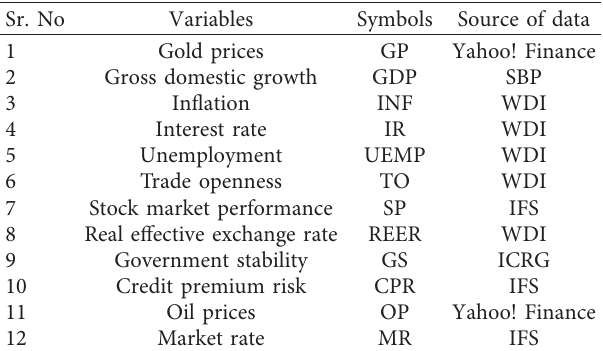
Table 3: Simulation results for Frechet distributed errors. Table